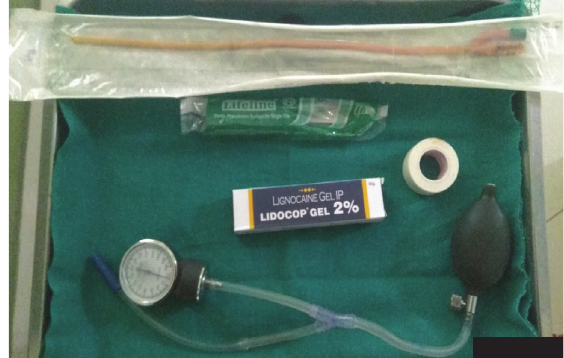
Figure 1. Locally assembled equipment used